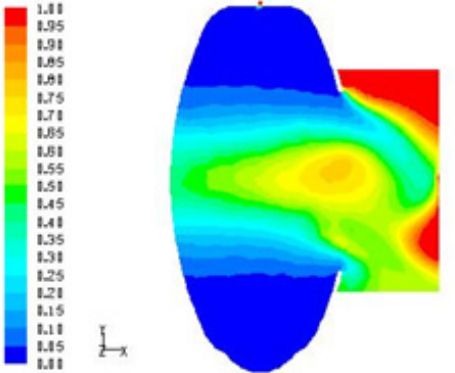
Fig. 4-2. Phase interface, Δ p = 20 kPa, reduced outlet.